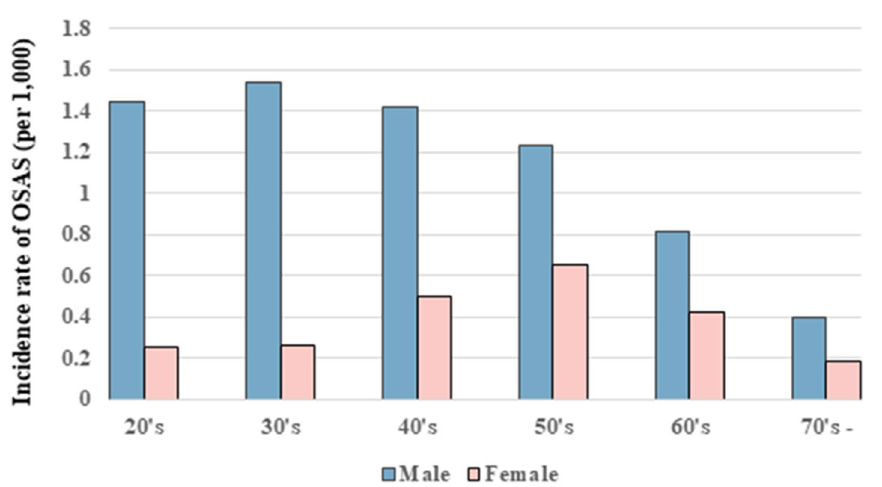
Figure 2. Incidence of OSAS according to age (for the